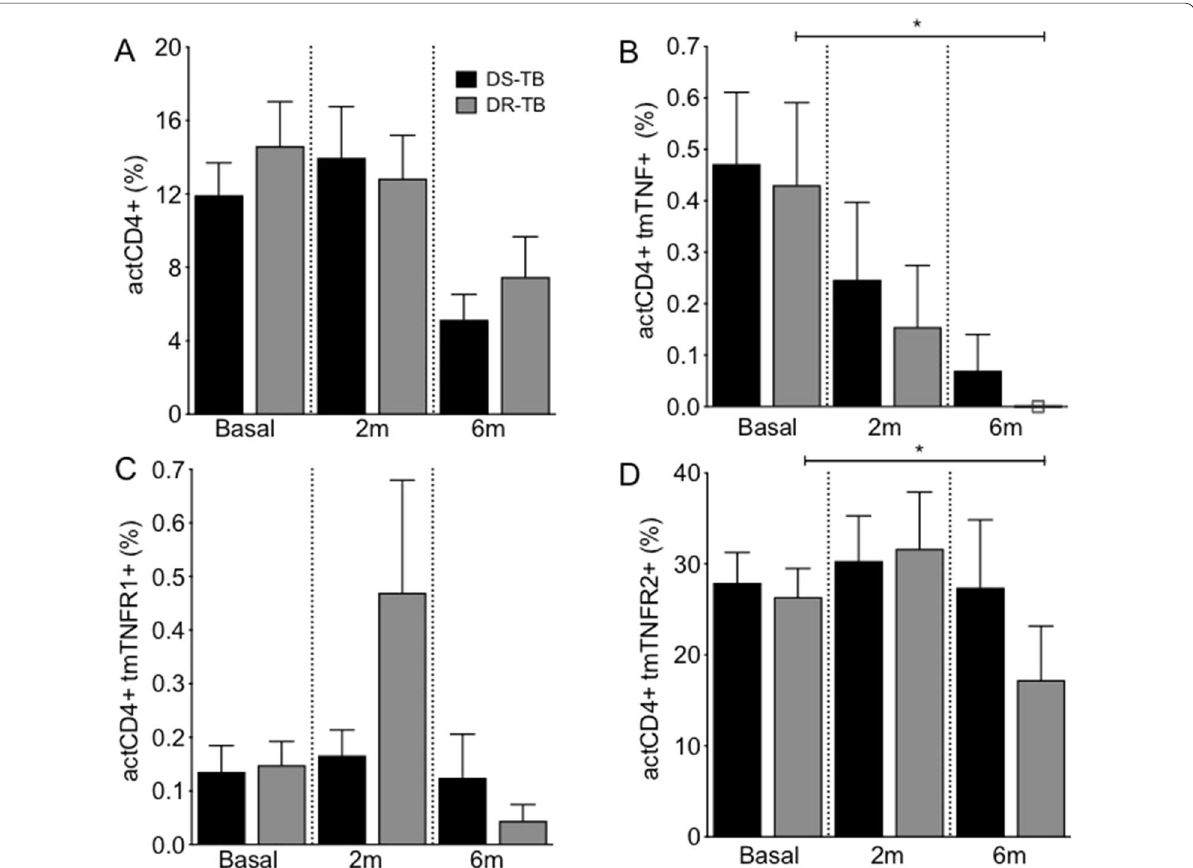
Fig. 3 Frequency of actCD4 tmTNF and actCD4 TNFR2 T cells decrease in response to anti‑TB therapy in DR‑TB. Peripheral mononuclear + + + + cells from drug‑susceptible (DS‑TB) and drug‑resistance (DR‑TB) tuberculosis patients were obtained at diagnosis time (basal), 2 months (2 m), and 6 months (6 m) of use of anti‑TB therapy, and then they were prepared for flow cytometry. For analysis, a gate of CD3 (activated CD4 T cells, actCD4 ) was identified. Then, the expression of tmTNF, tmTNFR1 and tmTNFR2 on actCD4 + + The frequency of actCD4 cells was obtained at basal, 2 m and 6 m of anti‑TB therapy. Frequency of actCD4 + ( C ) and tmTNFR2 ( D ) were evaluated. DS‑TB n 11, DR‑TB n 7. Bar graphs showing the mean = = multiple comparisons tests (*p <